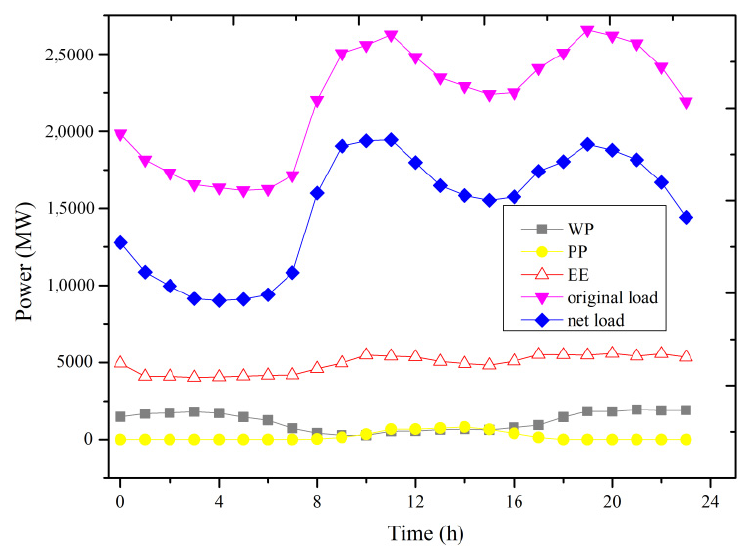
Figure 4. Input Data of Typical Day.